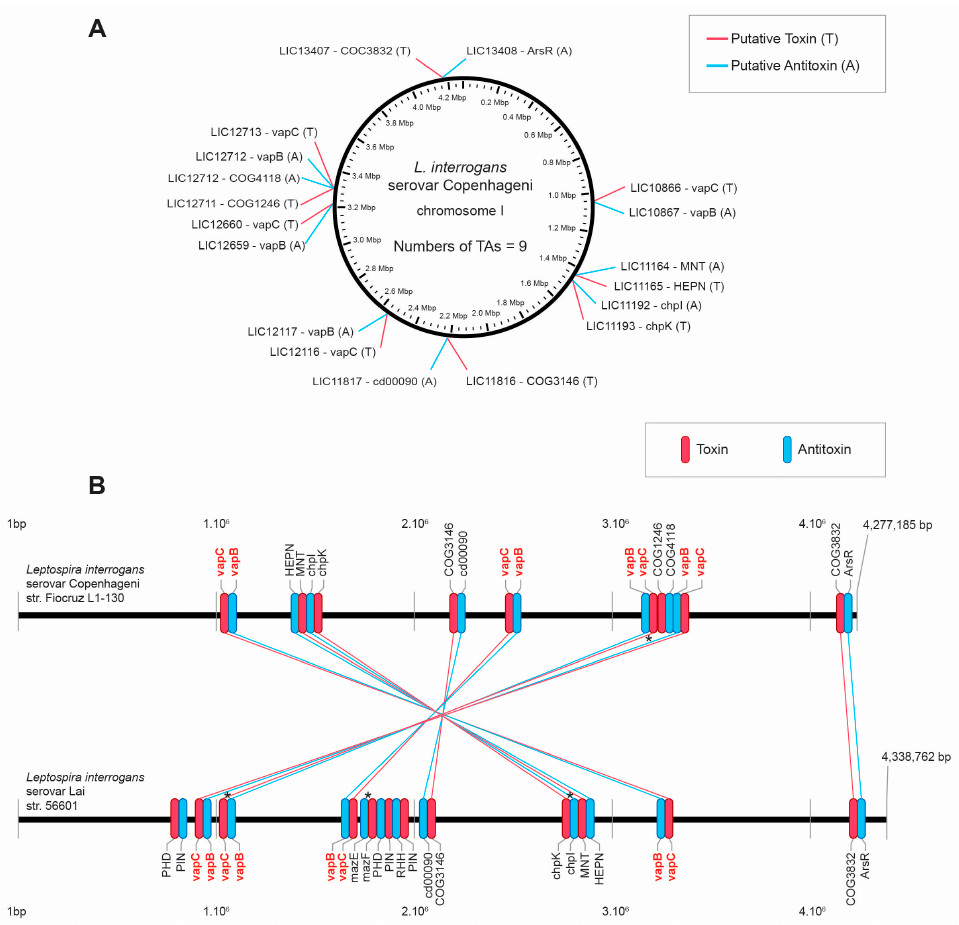
Figure 1. ( A ) Location map of toxin-antitoxin (TA) type II systems on the chromosome of L. interrogans serovar Copenhageni. ( B ) Comparison of the TAs sets of L. interrogans serovar Copenhageni and L. interrogans serovar Lai. In this schema, horizontal black lines represent the chromosomes of Copenhageni and Lai serovars. Red and blue lines indicate the amino acid sequence correspondence of toxins and antitoxins, respectively. Identity between linked toxins is greater than 90%. Toxins and antitoxins are identified by family or domains, as they appear in TAfinder. * denotes TA modules that were experimentally characterized and published.